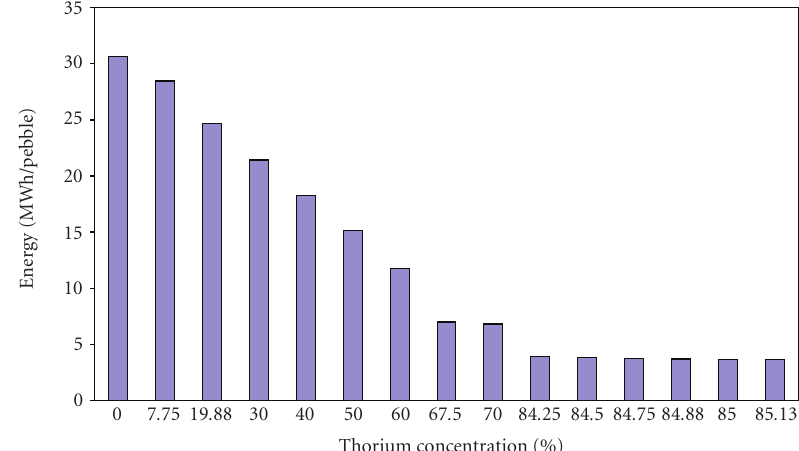
Figure 12: Produced energy (from BOC up to the time at which k -infinite becomes equal to unity) versus Th concentration.